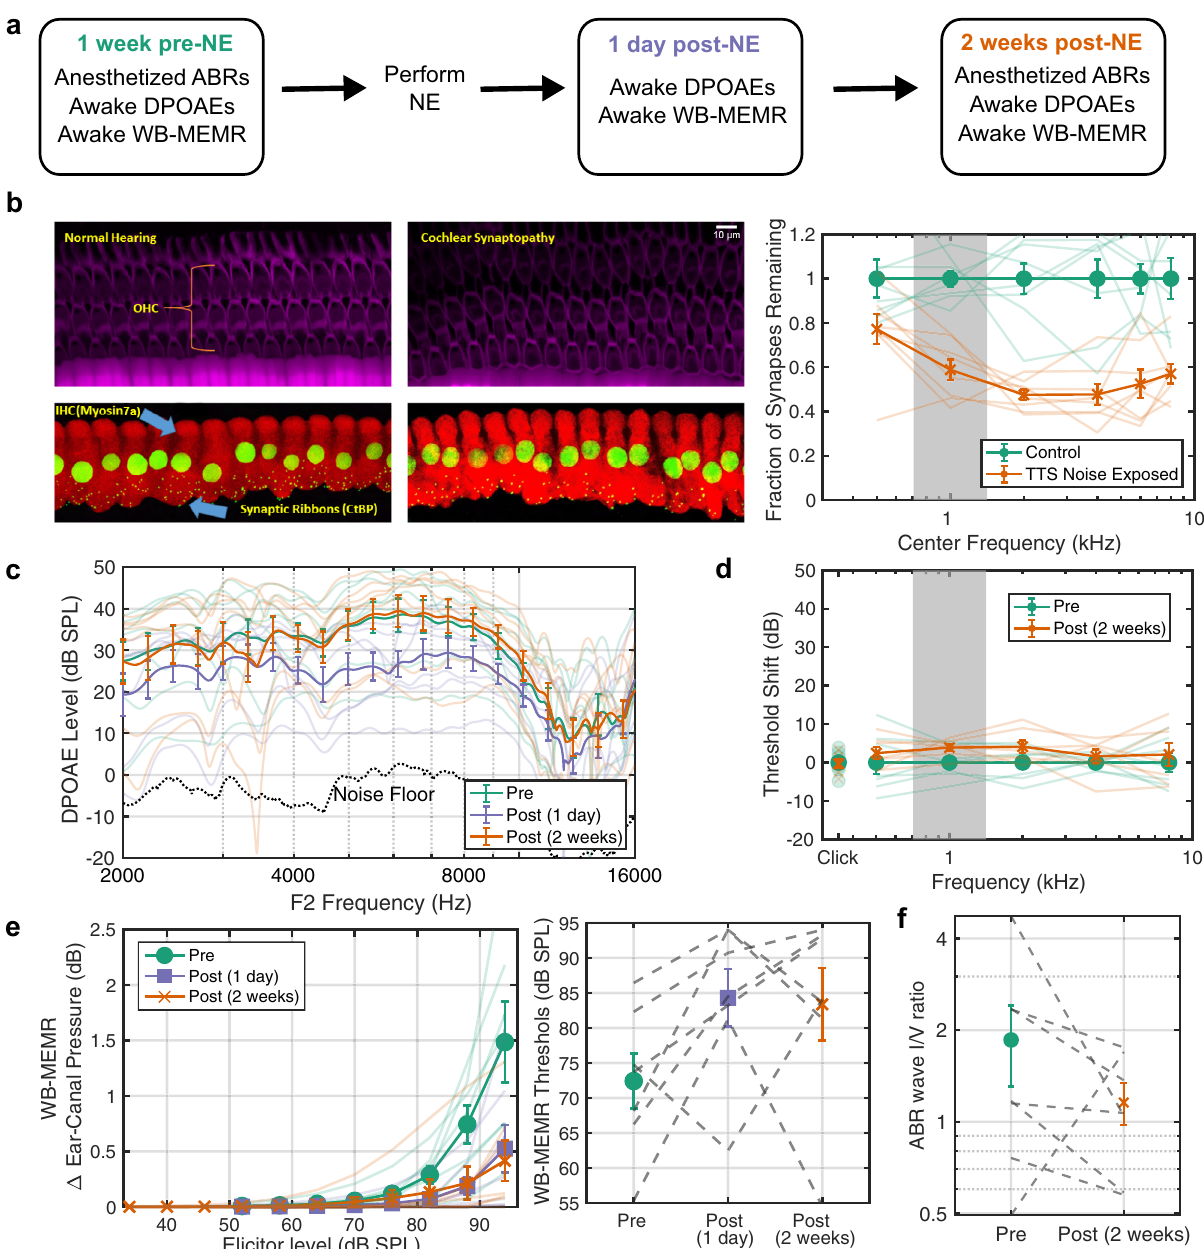
Fig. 1 Exposing chinchillas to octave-band noise causes TTS and transient DPOAE reductions but sustained CS, reduced WB-MEMR and suprathreshold ABR. a Exposure and measurement timeline. b Confocal imaging reveals broad CS following noise-exposure (NE), octave-band centered at 1 kHz indicated in gray. c Reduced DPOAE amplitudes 1-day post-NE, but full recovery by 2 weeks. d ABR thresholds at 2-weeks post-NE are within 5 dB of pre-NE levels. e Large (>50%) sustained reduction in WB-MEMR amplitudes and increased thresholds. f Reduced ABR wave-I/V ratio at 2-weeks post. All datapoints are estimated mean ± STE bars (N = 7). Measurements from individual subjects are shown as transparent lines color coded by whether the values were obtained pre-, 1-day post-, or 2-weeks post-NE ( a – d ; Left panel of e ), or as dotted gray lines (Right panel of e ; f ). Underlying data are archived on Zenodo (https://doi.org/10.5281/zenodo.6672827) 61